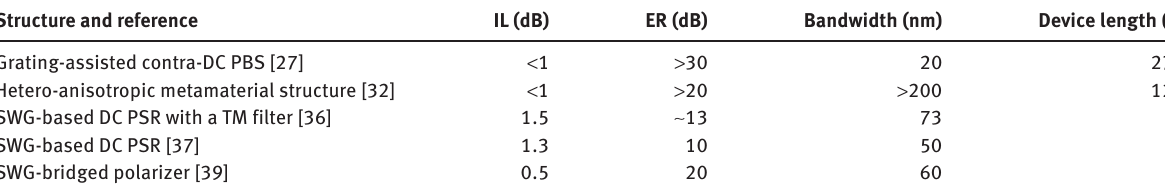
Table 1: Performance of some subwavelength structured polarization handling devices. Structure and reference